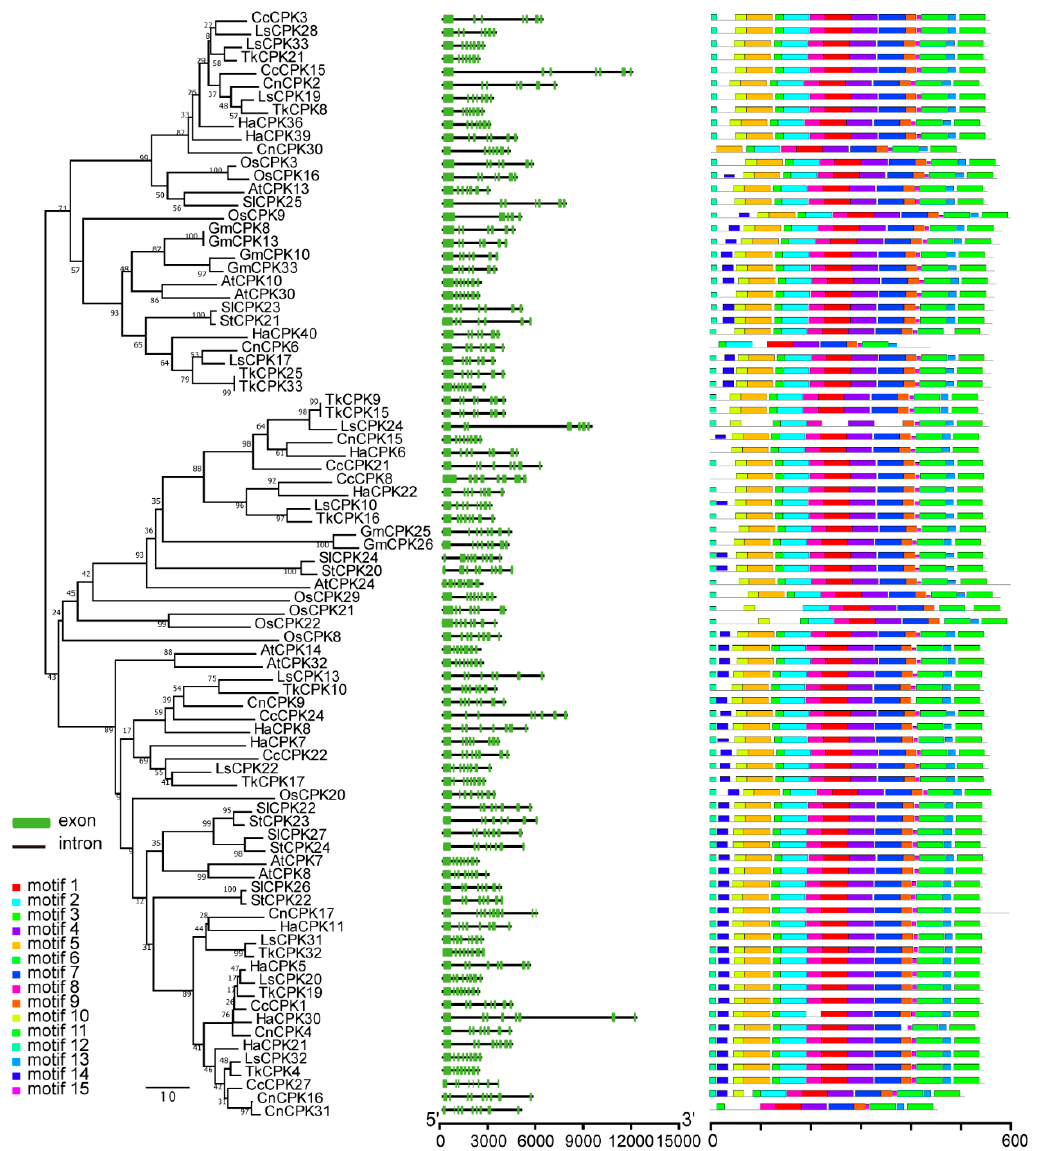
Figure 5. Gene structure and conserved motif distribution of group III CPKs from five model plants and five Asteraceae species. The phylogenetic tree-view is on the left panel. Exon–intron distribution is in the middle, in which black lines and green boxes represent introns and exons, respectively. The motif distribution is on the right panel, in which rectangles with different colors represent different conserved motifs.